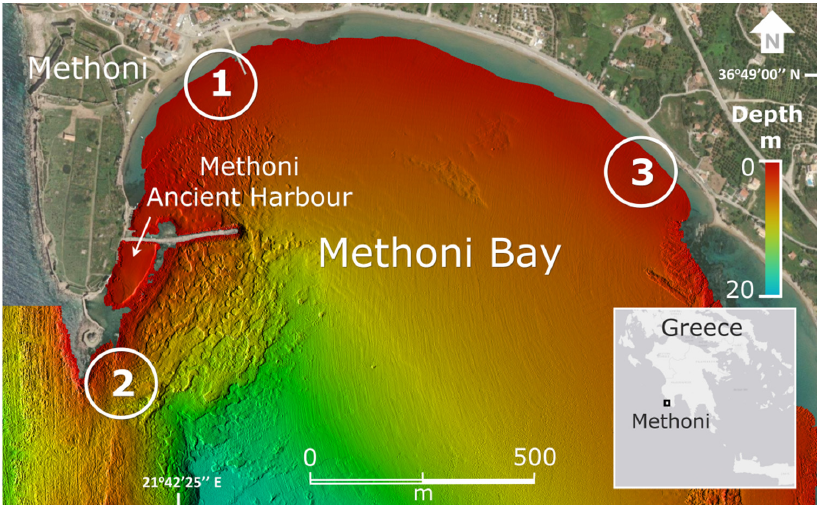
Figure 1. Distribution of shipwreck sites (numbered from 1 to 3) over the Methoni Bay. Colour-coded bathymetry is shown superimposed on the background map. Background map data source: Esri, DigitalGlobe, GeoEye, Earthstar Geographics, CNES/Airbus DS, USDA, USGS, AeroGRID, IGN and the GIS User Community.